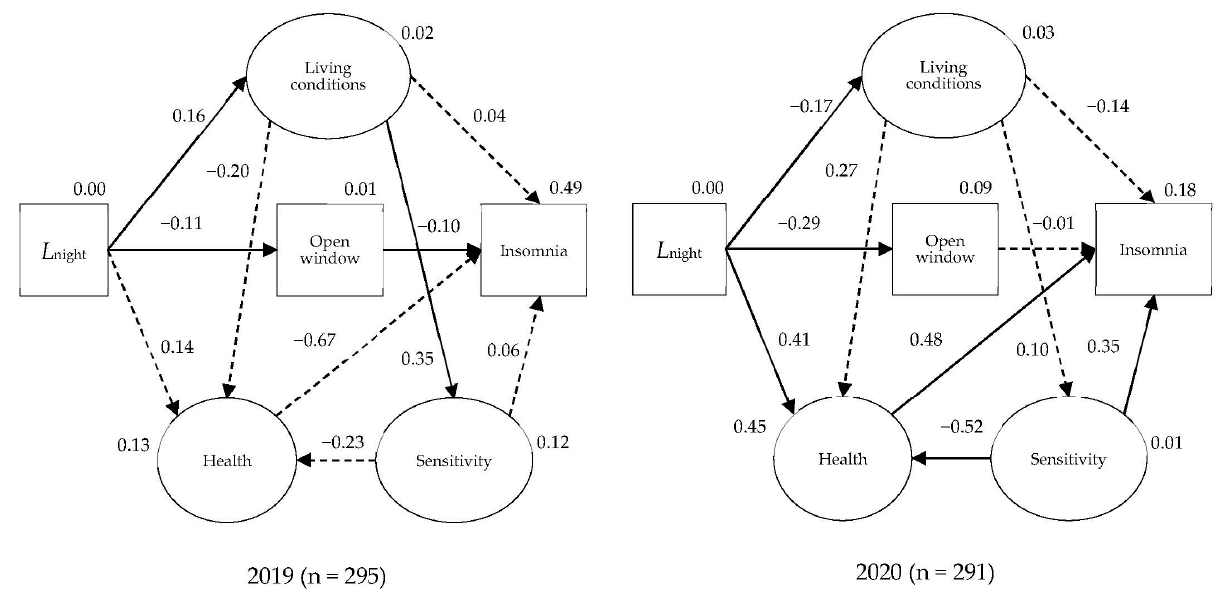
Figure 5. The structural equation model estimated for insomnia with the opening of the bedroom window variable in the 2019 and 2020 surveys using chi-square, GFI, CFI, and RMSEA statistics: chi-square = 275.578, p < 0.01, df = 94, GFI = 0.927, CFI = 0.894, and RMSEA = 0.058. Statistically significant paths and standardized regression weights were annotated with ( p < 0.05). The non-significant paths are represented by dashed lines. The explained variances are annotated for each variable. Table 13. Parameter estimates of the structural equation model for insomnia with the opening of the bedroom window during the dry